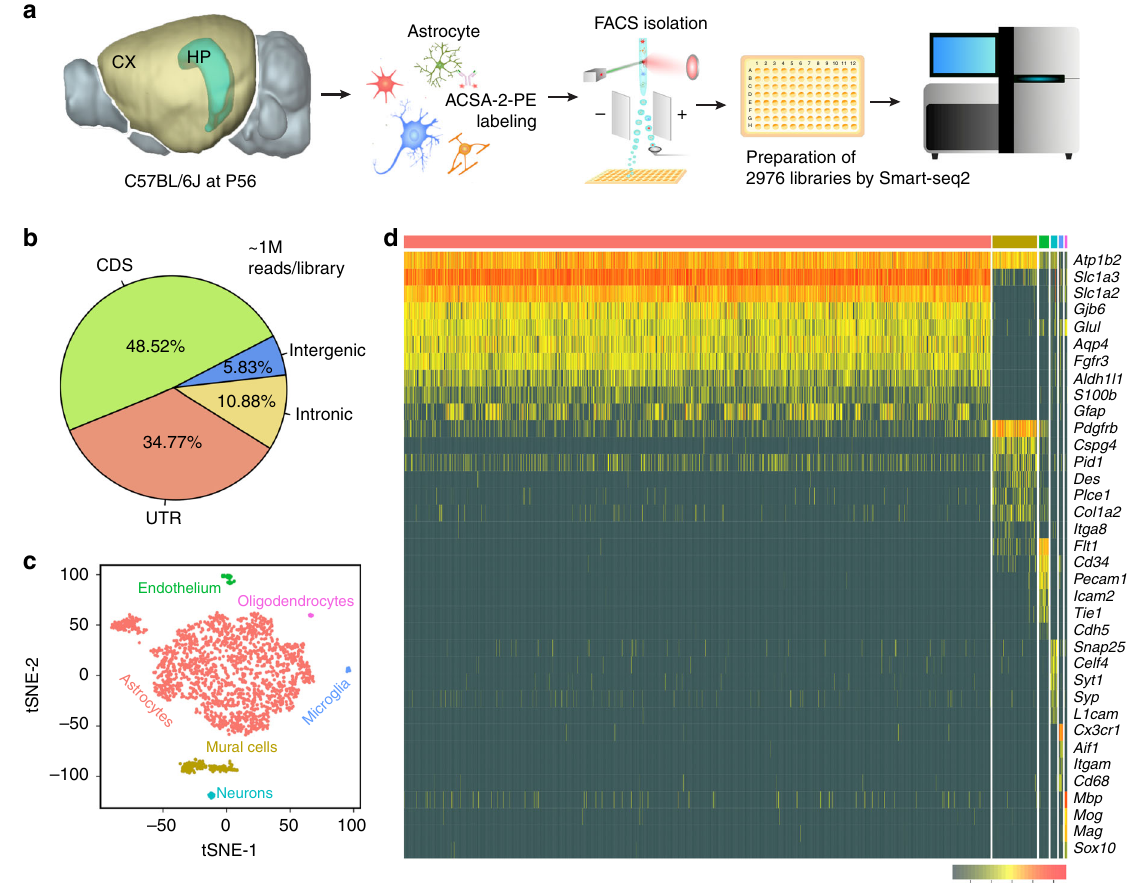
Fig. 1 Single-cell sequencing strategy and cell-type identi fi cation. a Whole brains were obtained from C57BL/6J mice at postnatal (P) day 56. Cortical (CX) and hippocampal (HP) astrocytes were prepared separately, using enzymatic digestion followed by mechanical trituration. Two separate batches of astrocytes for each region were prepared. Cortical cell suspensions were prepared from two littermate animals in parallel using separate tubes. Hippocampal cell suspensions were also prepared in parallel using separate tubes; in this case, two different sets of four littermate animals were used. Astrocytes were then speci fi cally labeled with the ASCA-2-PE antibody and single cells were deposited in individual wells of a PCR plate using FACS. Single-cell library preparation was performed using a modi fi ed Smart-seq2 protocol. In total, 2976 libraries were prepared and sequenced using a NextSeq 500 system (Illumina). b Each library was sequenced to optimal coverage (on average 1 M reads per library). In total, 2015 high-quality libraries were retained for further analysis. In these libraries, a high fraction of reads mapped to exons (CDS, coding sequence; UTR, untranslated region). Conversely, a low fraction of reads mapped to intronic and intergenic regions. c Visualization of the major higher-order cell types (2015 cells) identi fi ed by Seurat using tSNE plots. Each dot represents a single cell. Cells with similar molecular pro fi les group together; cell types were assigned according to the expression of speci fi c marker genes (and are labeled in different colors). d Gene expression heatmap for higher-order cell types (columns) grouped according to the Seurat classi fi cation shown in Fig. 1c. Color-coding from Fig. 1c is retained. Gray, no expression; yellow, low expression; red, high expression, In-normalized gene expression data is